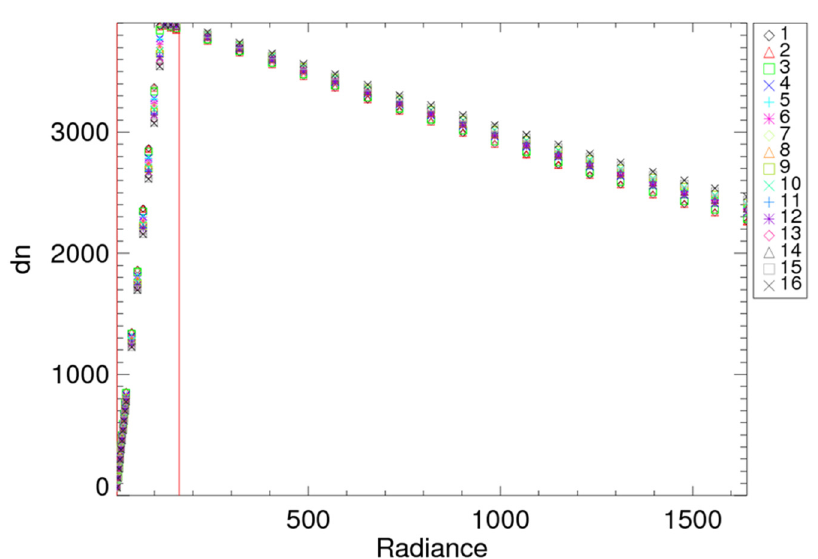
SIS100 radiance during the measurement.